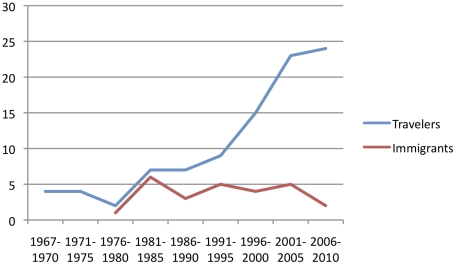
Sleeping sickness reported cases over the years in travelers.Note: The date refers to the date of diagnosis, not to the publication date of the case.